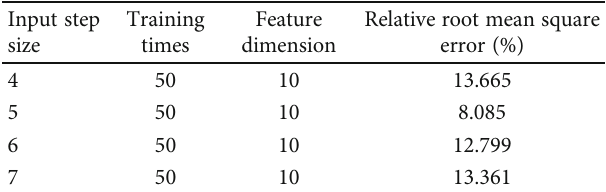
Table 3: Selection process